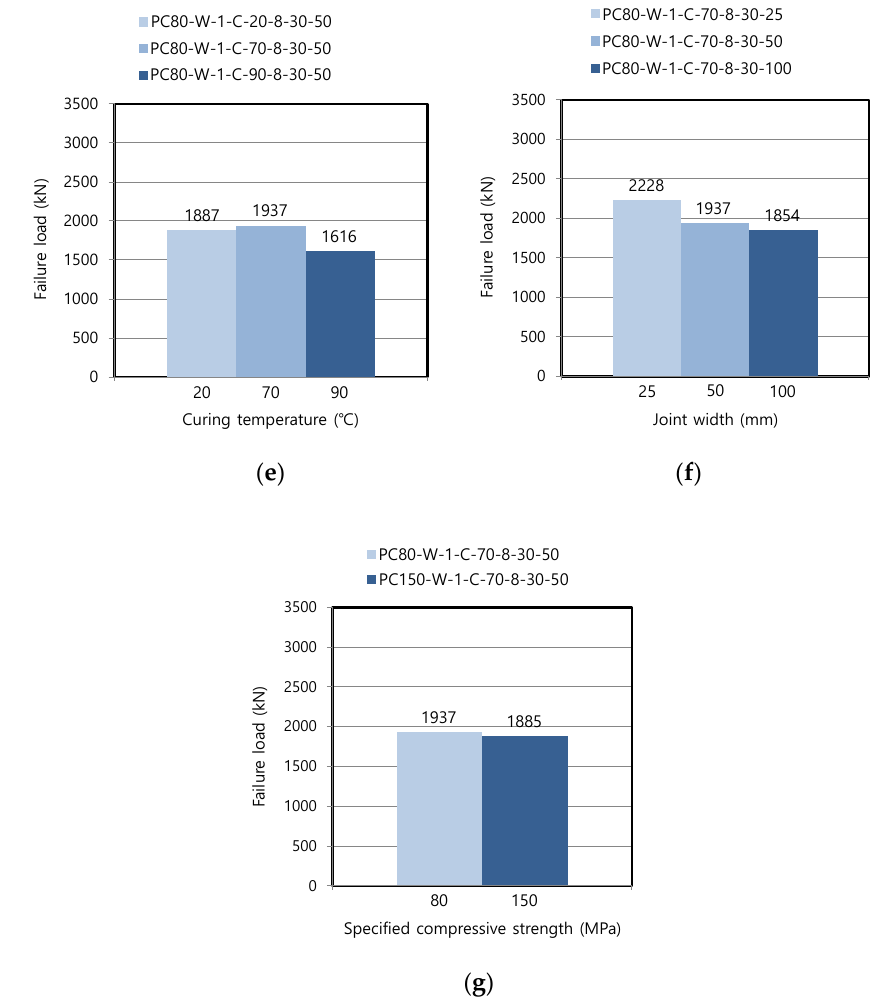
Figure 7. Failure loads in wet joint for each variable: ( a ) number of shear keys; ( b ) lateral compressive stress; ( c ) shear key height; ( d ) filler type; ( e ) curing temperature; ( f ) joint width; and ( g ) compressive strength.